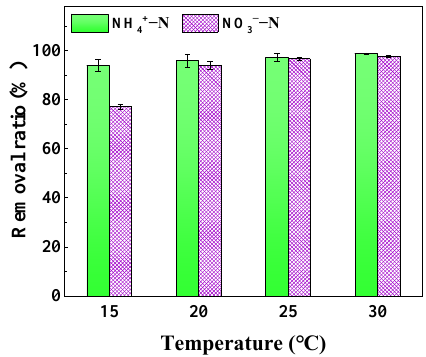
Figure 7. Influence of temperature on nitrogen compounds removal on Vibrio sp. LY1024.